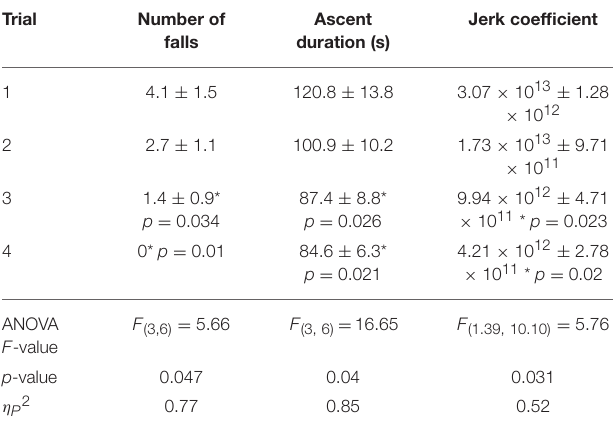
TABLE 3 | Effect of practice on the climbing states (i.e., number of events and total relative duration of the state expressed in % of the whole ascent duration).